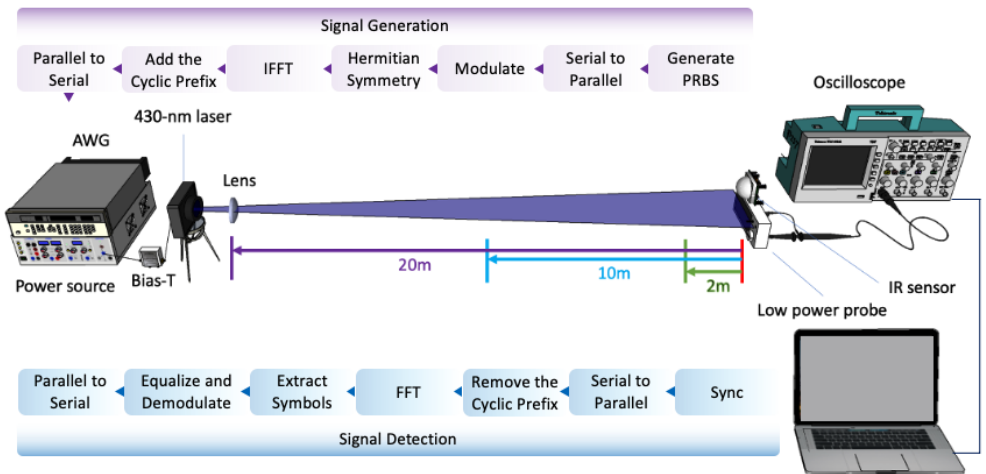
Figure 6. Data transfer experimental setup with the OFDM block diagram. The distance between the 430-nm laser source was set to 2, 10, and 20